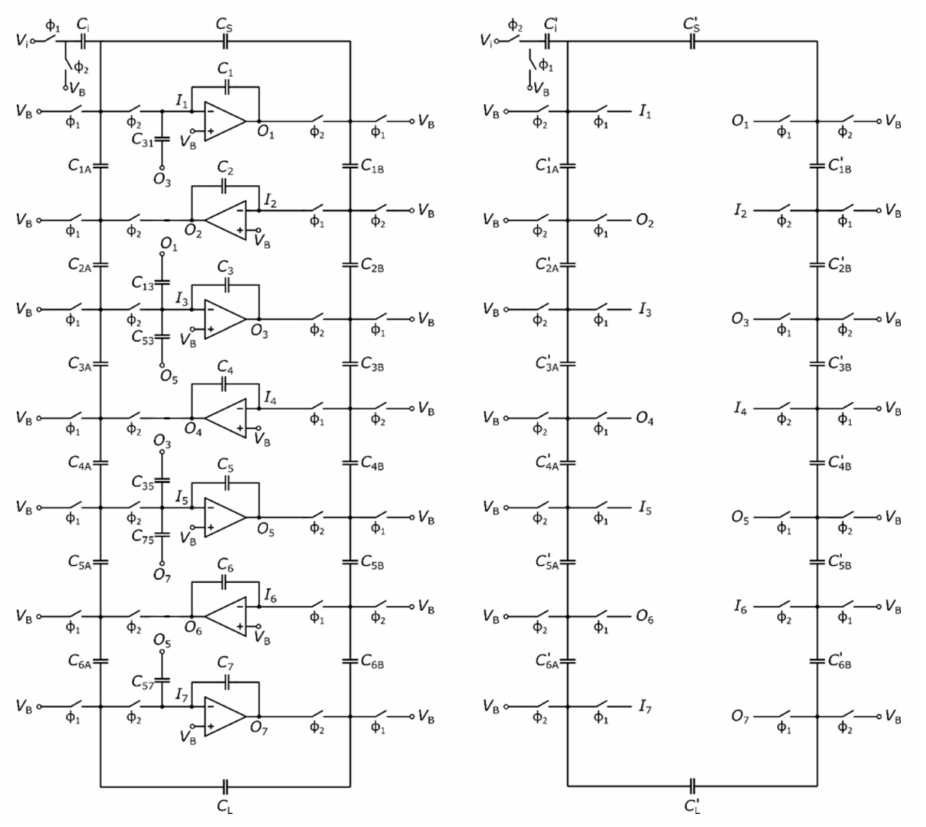
Figure 2. Single-ended simplified schematic of the proposed seventh-order SC LPF.